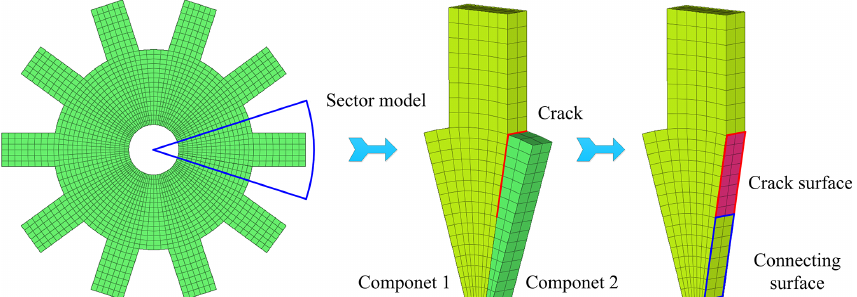
Figure 1. Finite-element model of a disk with a gapless crack.